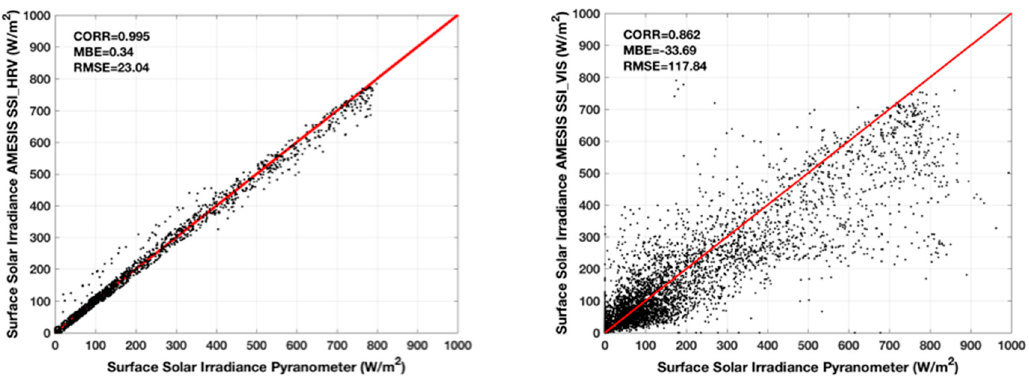
Figure 7. Same as Figure 5, but for partially cloudy sky. ( Left ): SSI_HRV product, ( right ): SSI_VIS product.